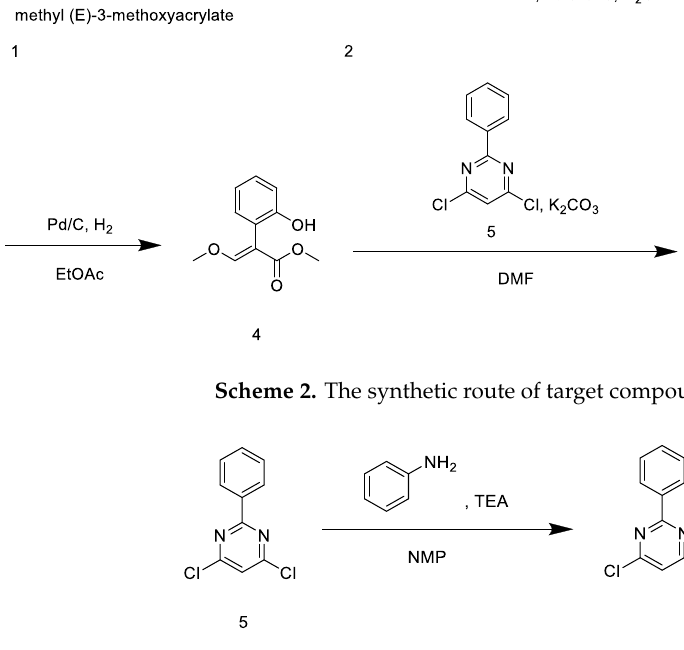
Scheme 3. The synthetic route of target compound 7 .